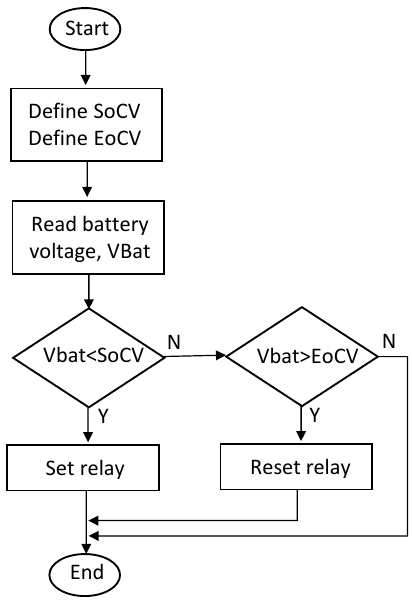
Figure 4. Flowchart for relay control.